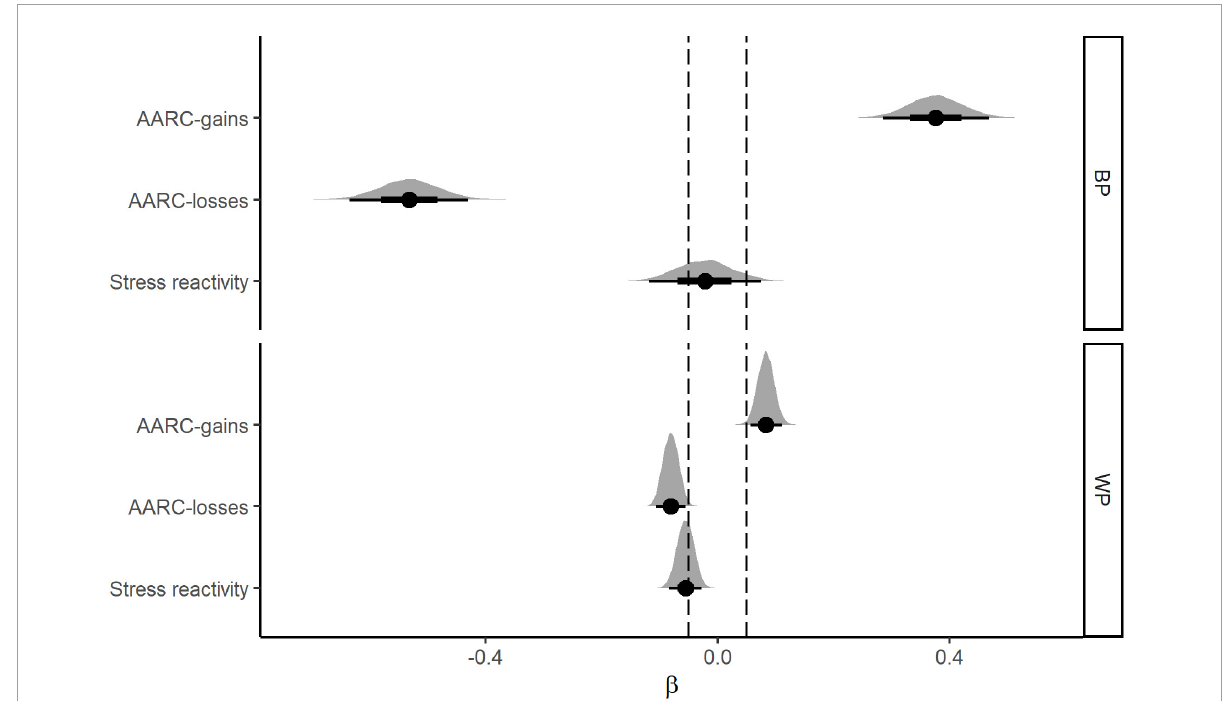
FIGURE3 Between-person (BP, top panel ) and Within-Person (WP, bottom panel ) main effects for AARC and stress severity as predictors of vitality. The figure shows posterior distributions of coefficient estimates for the main effects and their degree of overlap with the region of practical equivalence (ROPE 0 . 05